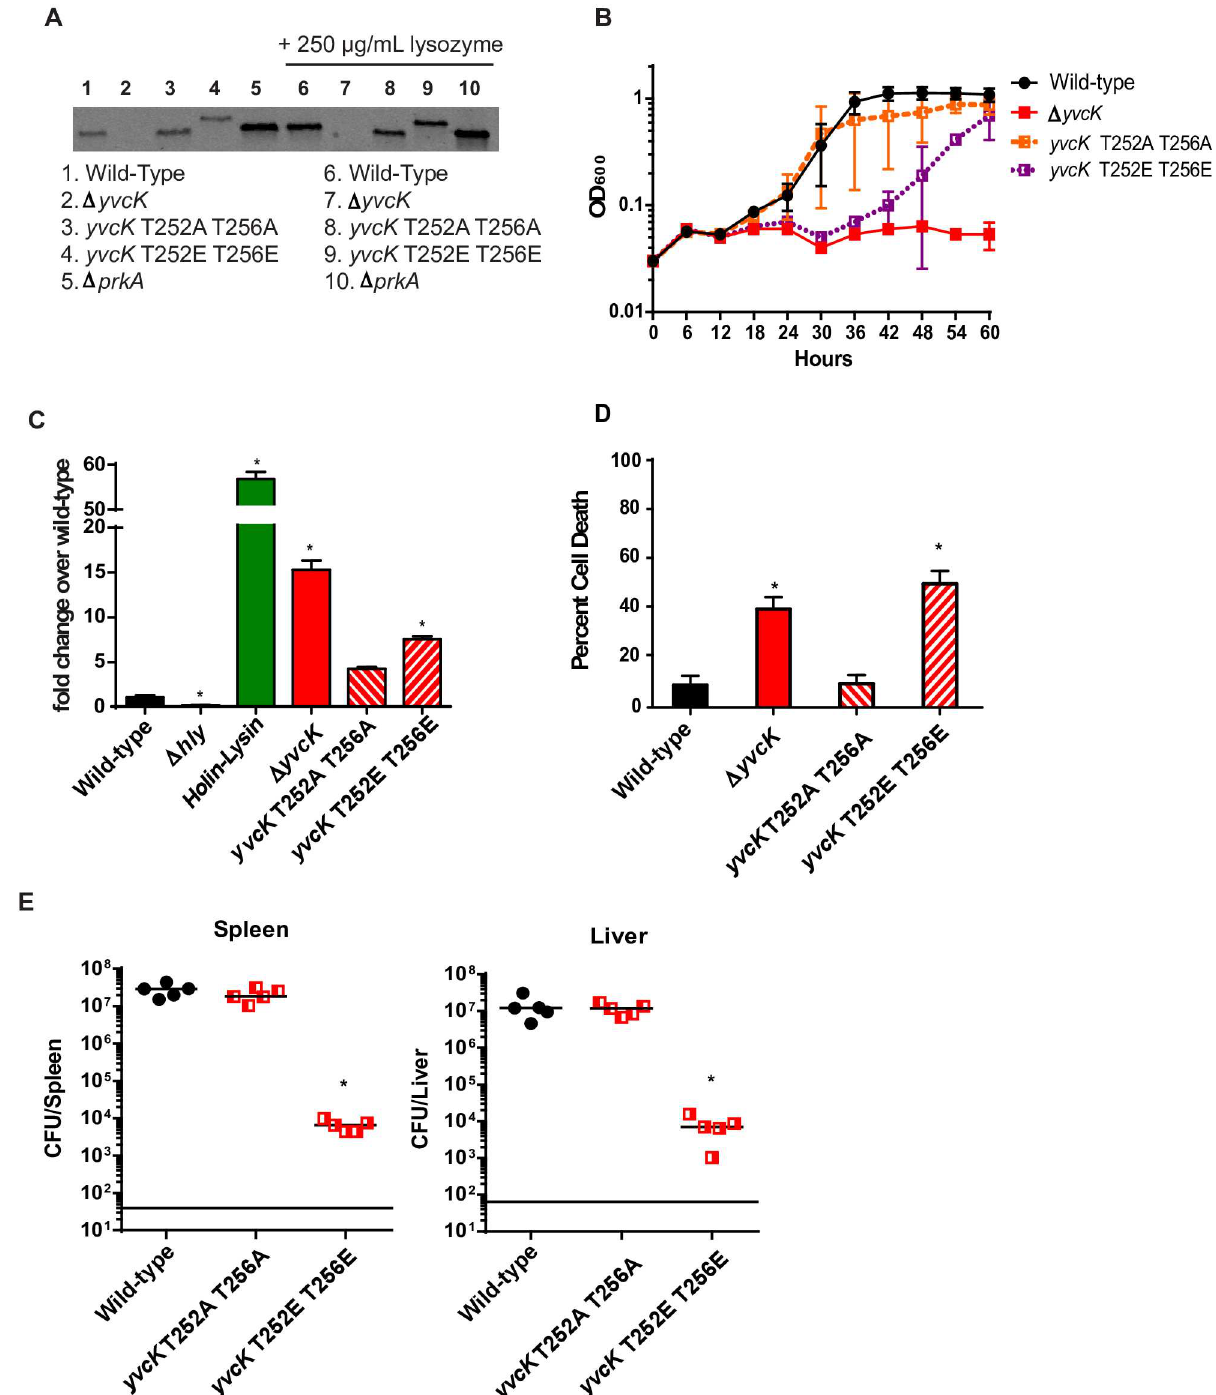
Fig 5. Phosphomimetic YvcK mutants phenocopy Δ yvcK mutant ex vivo and in vivo , but not in vitro . (A ) Expression of YvcK in wild-type, Δ yvcK , yvcK T252A T256A, yvcK T252E T256E, and Δ prkA at mid-login BHI (1–5) or with 250 μ g/mL (6–10). (B) Growth of wild- type (black circles), yvcK T252A T256A (orange squares filled on the left side), yvcK T252E T256E (purple squares filled on the right side) in IMM with glycerol as the sole carbon source. Data are averages of three biologicalreplicatesand error bars represent standard deviation of the mean. (C) Intracellular lysis of L . monocytogenes was measured in immortalizedIFNAR -/- macrophages. Macrophages were infected at an MOI of 5 by L . monocytogenes strains carrying pBHE573and macrophageluciferase expression was measured 6 hours post infection. Mean values are reported. Experiments are representative of three or more biologicalreplicatesand error bars represent the